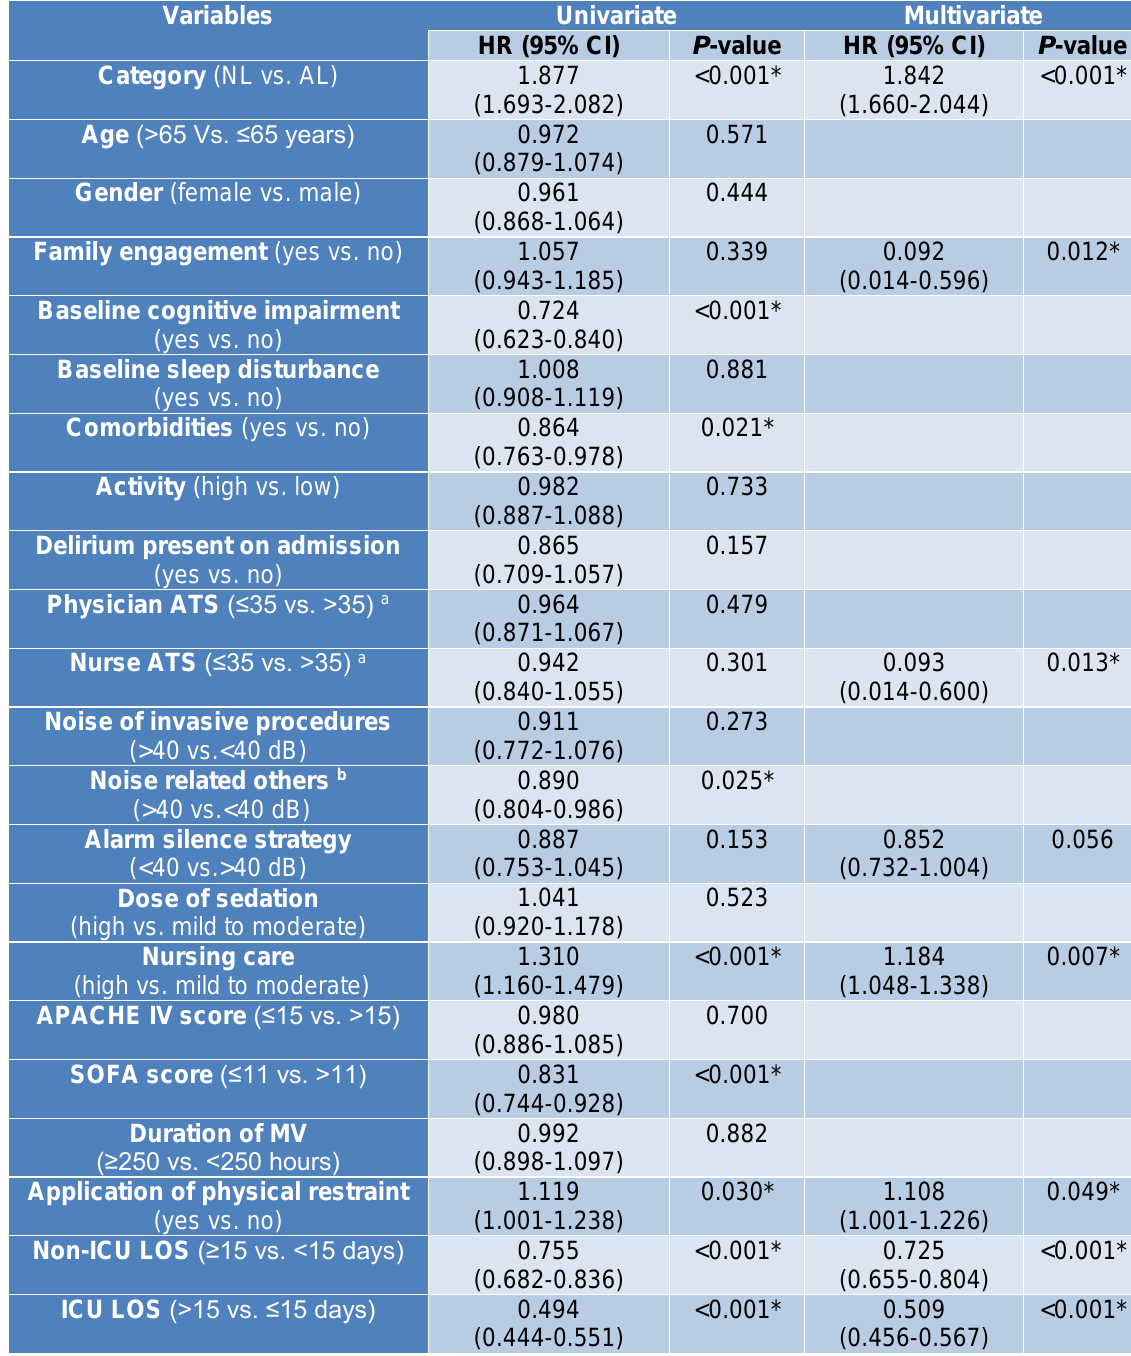
Table 2: Univariate and multivariate Cox regression analysis of influencing factors to predict delirium incidence Variables